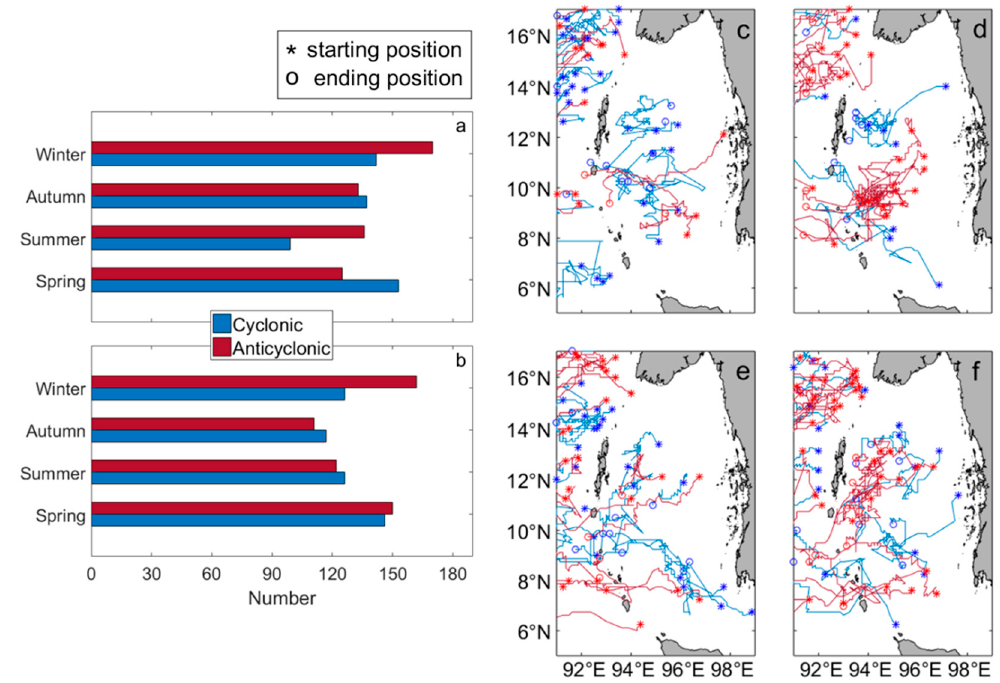
Figure 19. In the Andaman Sea, eddies with a life cycle of not less than 4 weeks produce ( a ) and die ( b ) seasonal changes, and the propagation map of eddies with a life cycle of not less than 10 weeks is ( c ) spring ( d ) summer ( e ) autumn ( f ) winter.